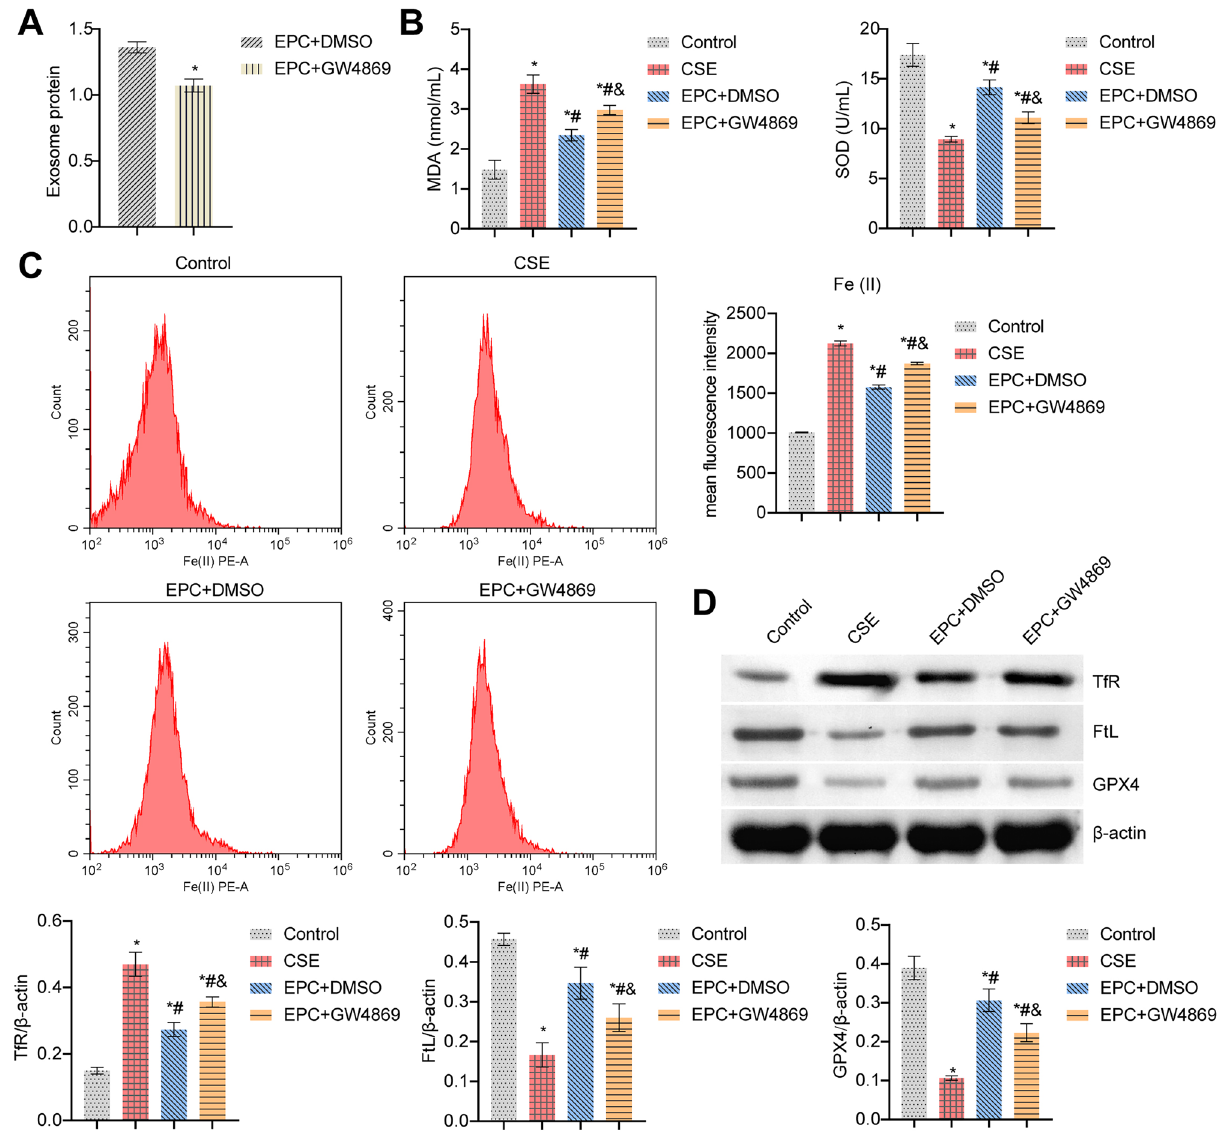
Figure 1. EPC alleviated CSE-induced ferroptosis in BECs by transporting Exo. ( A ) The concentration of Exo in the cell supernatant was evaluated by ELISA. *P < 0.05 vs. EPC + DMSO. ( B ) MDA and SOD levels in the cell supernatant were determined by ELISA. ( C ) The relative content of catalytic Fe (II) in BECs was detected by FCM. ( D ) Western blot detection of ferroptosis markers TfR, FtL, and GPX4 expressions in BECs. *P < 0.05 vs. Control, #P < 0.05 vs. CSE, &P < 0.05 vs. EPC + DMSO. The data were presented in the form of mean ± standard deviation. n =